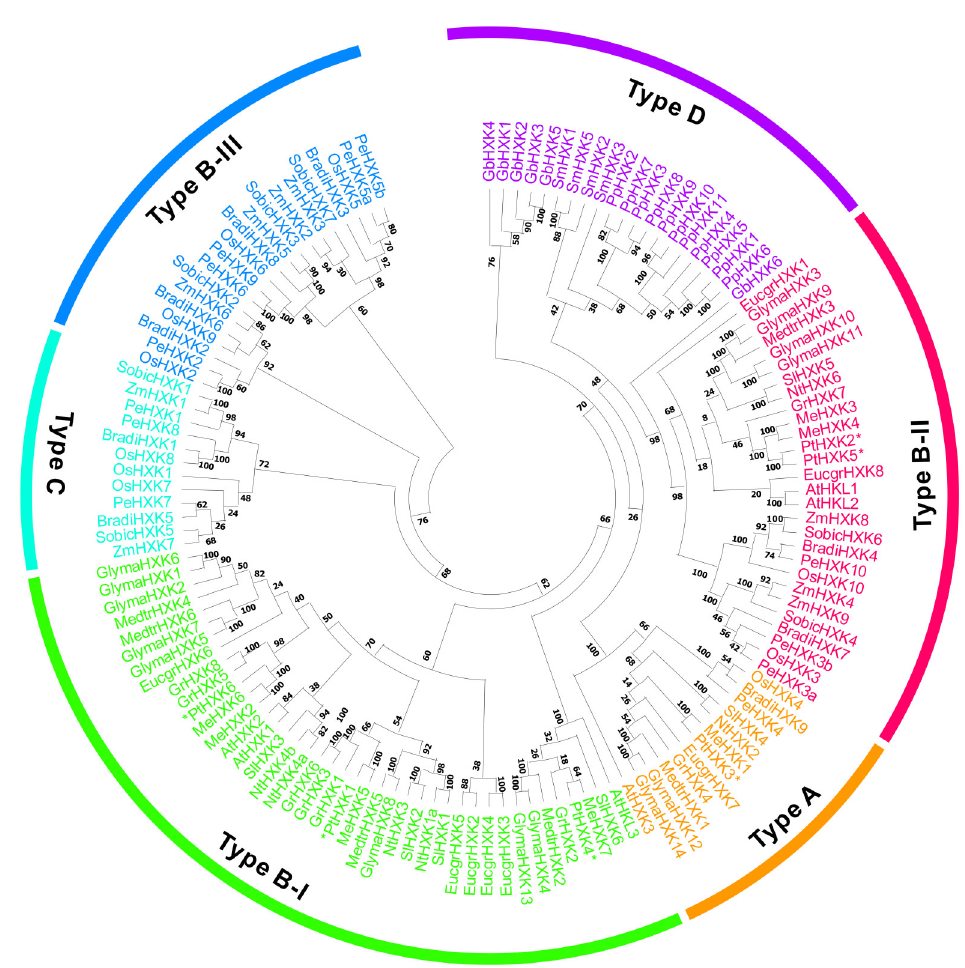
Figure 1. Phylogenetic relationships of clustered homologous HXKs between 17 plant species. The evolution tree was generated using the Maximum Likelihood method in MEGA X with 1000 bootstrap replicates. The four classified HXKs subgroups were represented as type A, B, C, and D.